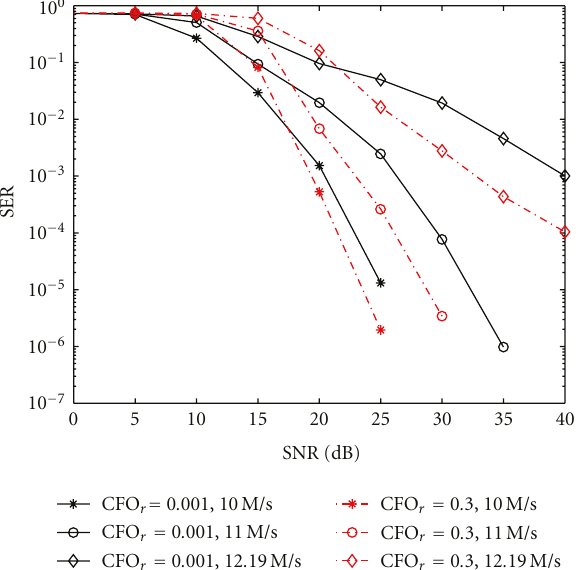
Figure 12: SER performance comparison for random delay only and di ff erent amounts of